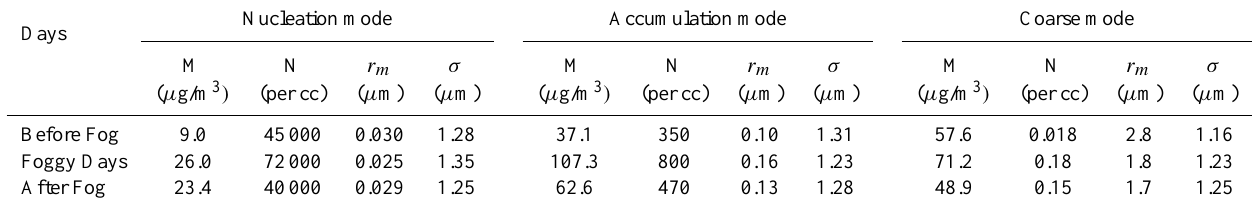
Table 1. Aerosol mass concentration (m), number concentration (N), mode radius ( r m ) and width ( σ) of the fitted lognormal distributions for the nucleation mode ( r< 0.1 µ m), accumulation mode (0.1 <r< 1.0 µ m), and the coarse mode ( r> 1.0 µ m).